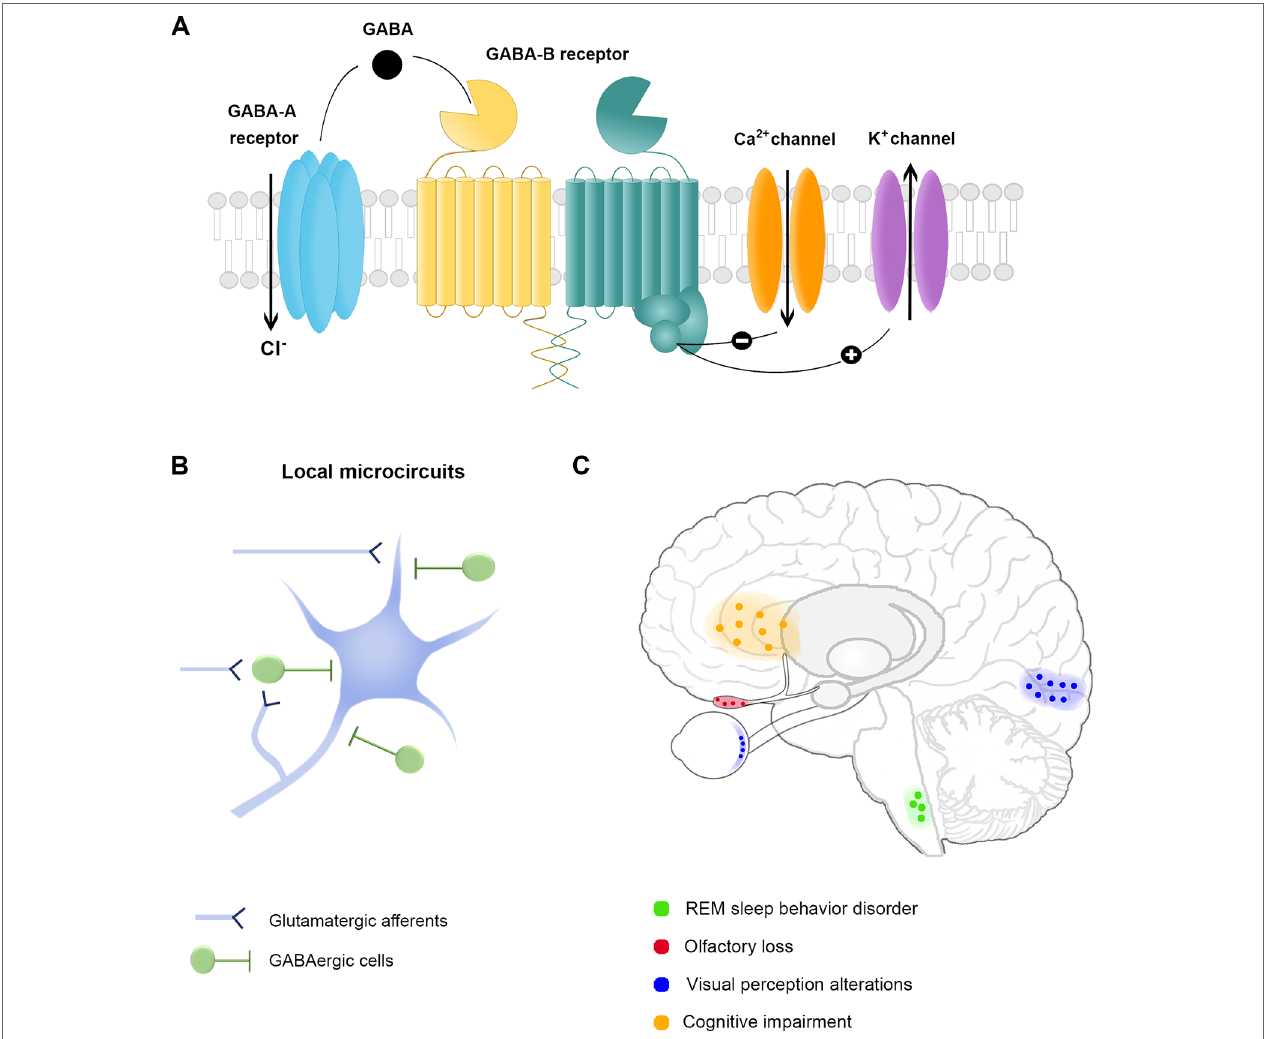
FIGURE 1 | The GABAergic system and non-motor symptoms in Parkinson’s Disease. (A) GABA receptors. The inhibitory neurotransmitter GABA acts through ionotropic GABA A receptor or metabotropic GABA B receptor to reduce the membrane potential. The activation of GABA A receptors allows chloride (Cl - ) entry into the cytoplasm, while GABA B receptor activation leads to a cellular cascade resulting in calcium (Ca 2+ ) channel deactivation and potassium (K + ) channel opening. (B) Schematic representation of cortical and subcortical local microcircuit organization of GABAergic cells. Inhibitory GABAergic cells are primarily local projecting neurons with a broad array of anatomical and physiological properties. The effect resulting from the inhibition exerted by GABAergic cells depends on their sensitivity to incoming stimuli, their firing properties and the subcellular domain of excitatory cells targeted by each interneuron. The diversity of GABAergic cells provides the brain with extensive computational power to regulate sensory and cognitive processes. (C) Brain areas associated with non-motor symptoms in Parkinson’s disease. Each color corresponds to a specific non-motor symptom and the associated area of the presumed GABAergic dysfunction.